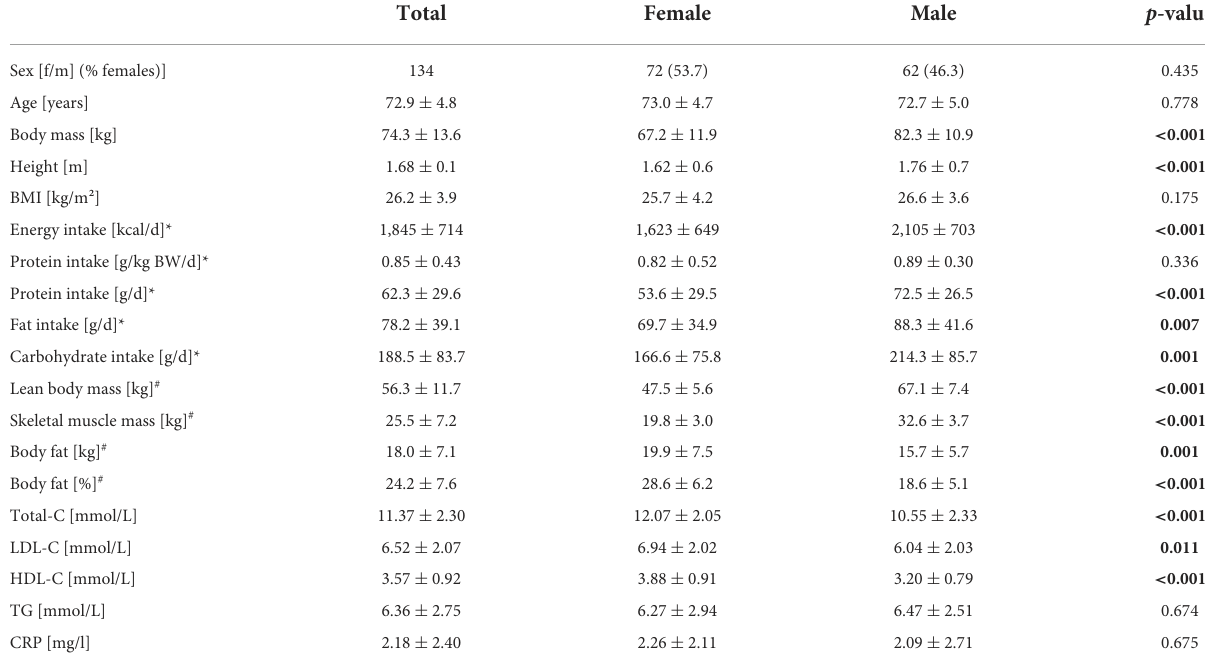
TABLE 1 Baseline characteristics.